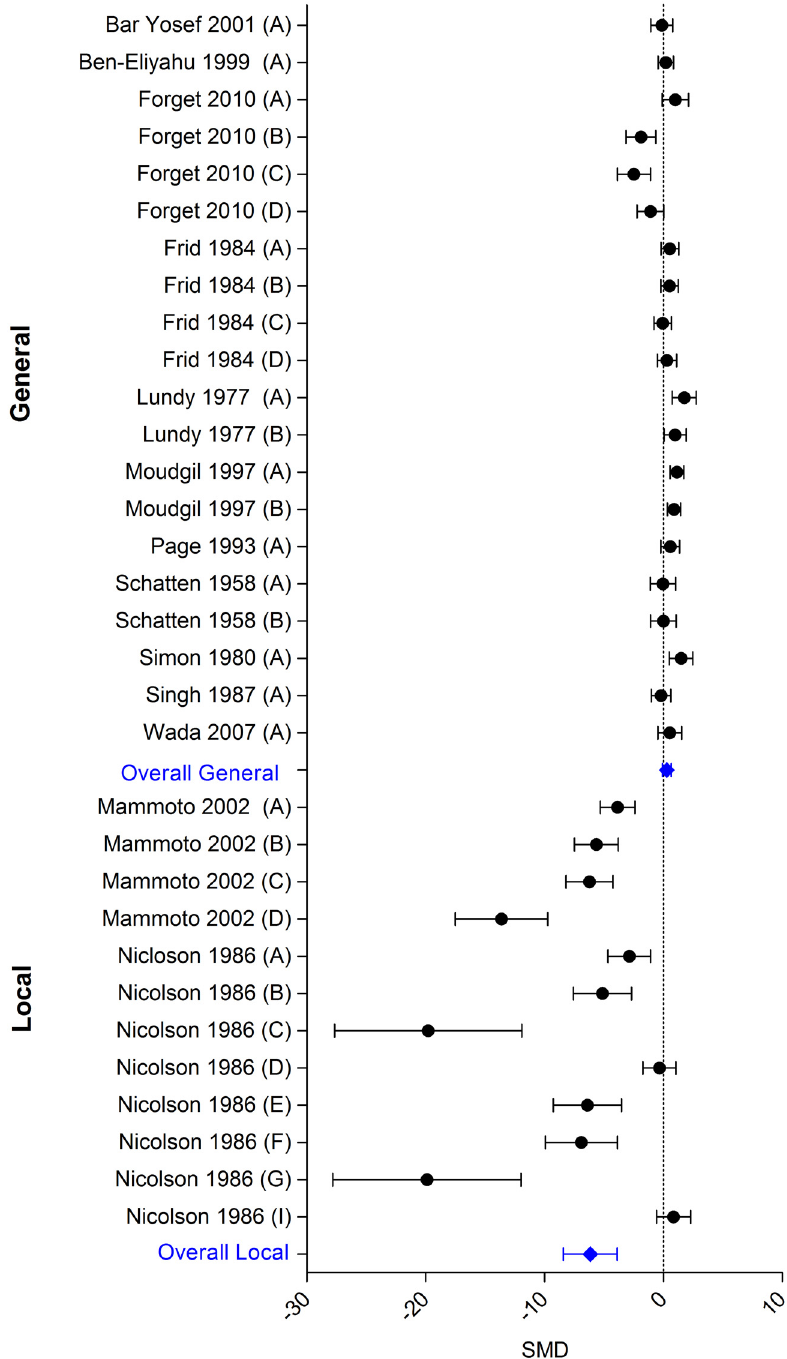
Fig 3. Forest plot of the impact of general and local anaesthetics on the number of metastases. Left side: reduced number of metastases; right side: increased number of metastases. An overall beneficial effect of local anaesthetics was observed. General anaesthetics do not have an effect. Data presented as SMD and 95% CI.